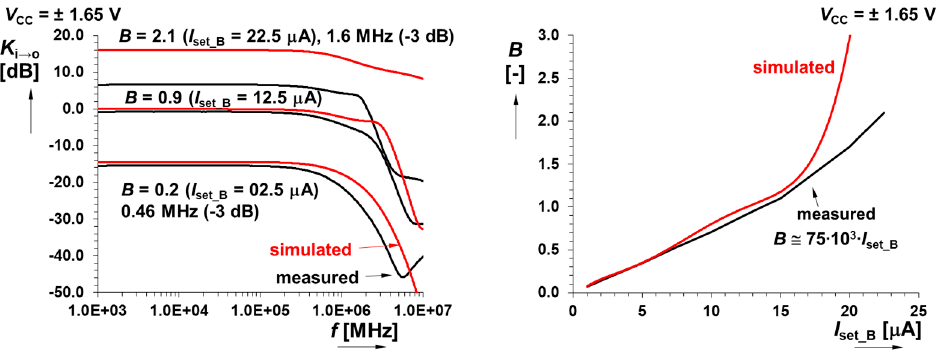
Figure 10. Selected results of the measured and simulated responses of the CA: (left) AC responses of i → o transfers; (right) dependence of B on I set_B .